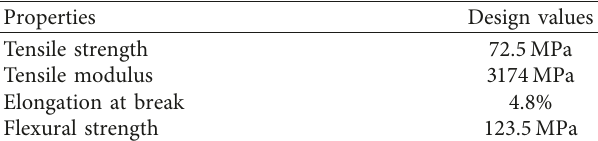
Table 3: Type 1 epoxy properties.